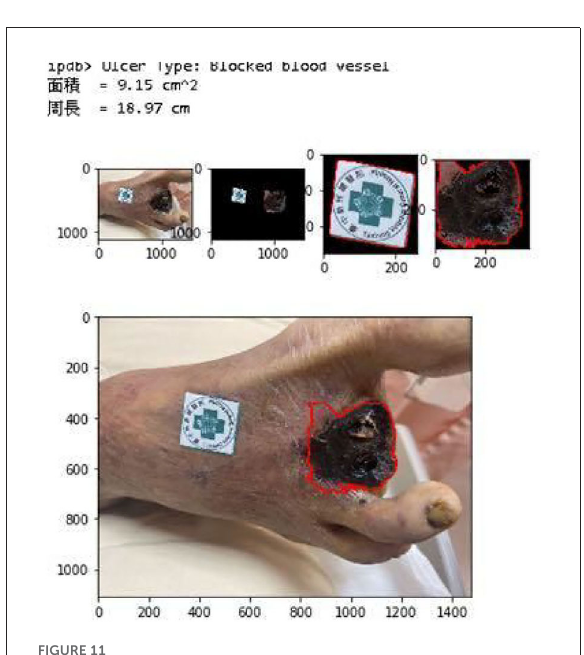
FIGURE11 Wound characteristic computation. The top row shows the ulcer type information, and the area and perimeter of the wound. The middle row shows the segmentation of the wound and marker during our evaluation. The last row shows the contour marked with a red